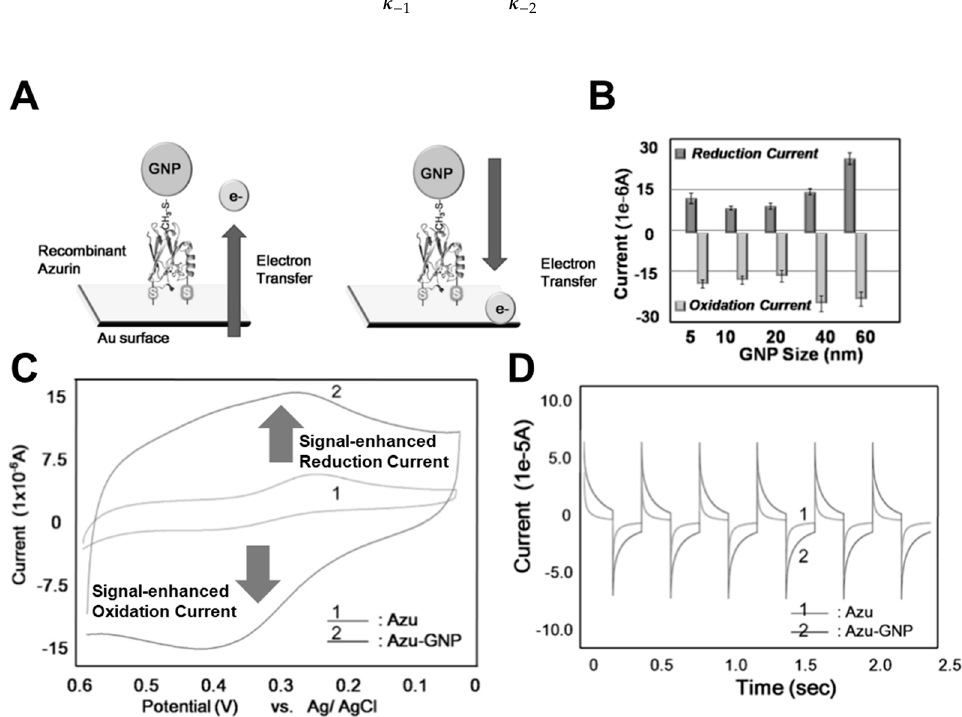
Figure 3. Electrochemical signal enhanced biomemory device. ( A ) Schematic image of the biomemory device composed of Azu and gold nanoparticles (GNP). ( B ) Redox potential peak values for optimizing the GNP diameter. ( C ) Cyclic voltammogram of Azu–GNP and Azu. ( D ) memory performance of Azu–GNP and Azu. (Reproduced with permission from [17], published by John Wiley and Sons, 2011).